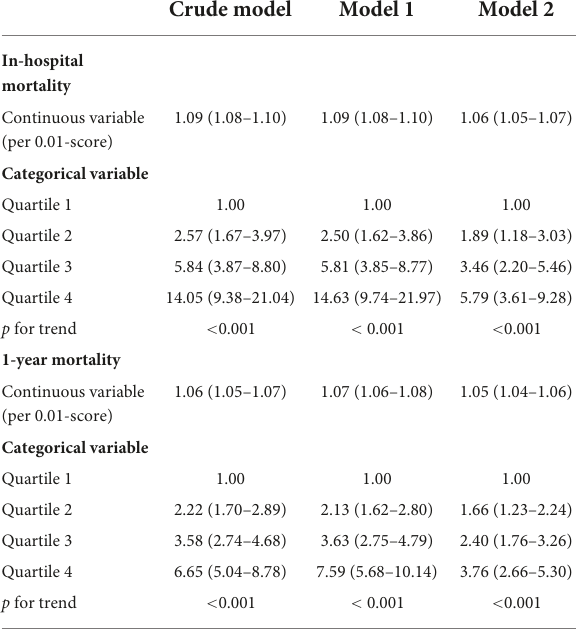
TABLE 3 Association of frailty index based on laboratory tests (FI-Lab) with in-hospital and 1-year mortality. Crude model Model 1 Model